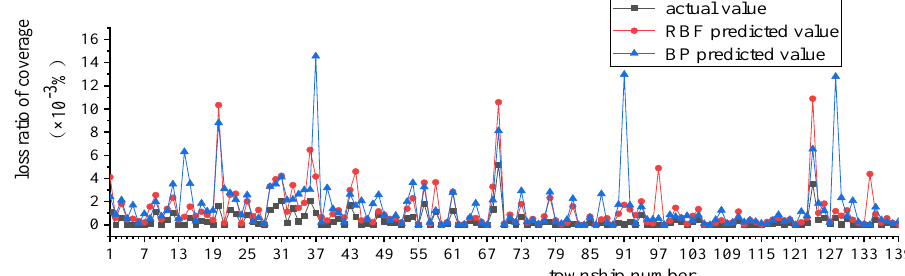
Figure 11. Model training curve. ( a ) BP neural network. ( b ) RBF neural network. To calibrate the models, the predicted values of the BP and RBF neural network models were compared with the actual values (i.e., the average insured loss rate of rural housing under the impact of five typhoons in 2019) and the mean square error was used as the evaluation indicator. The results are shown in Figures 12 and 13. A total of 139 townships in Ningbo were numbered sequentially. It can be seen that both two models could accurately predict the insured loss rate for most townships. However, due to the single input typhoon causal factor (i.e., simulated typhoon wind speed) and the small training sample size (i.e., 20 typhoon damage samples), the two models were less effective in predicting some townships with sudden changes in insured loss rates. In addition, both the BP model and the RBF model had a limited prediction effect for the townships with 0 insured loss rate. Therefore, the predicted values of insured loss rate for some townships were overestimated. In Figure 13, it is noteworthy that the maximum mean square error of the BP model was 18 × 10 − 6 , which was less accurate and had a larger fluctuation in the error range than the RBF model with a maximum mean square error of 8 × 10 − 6 . Overall, the mean square error of the predicted values of the RBF neural network was smaller than that of the BP neural network.